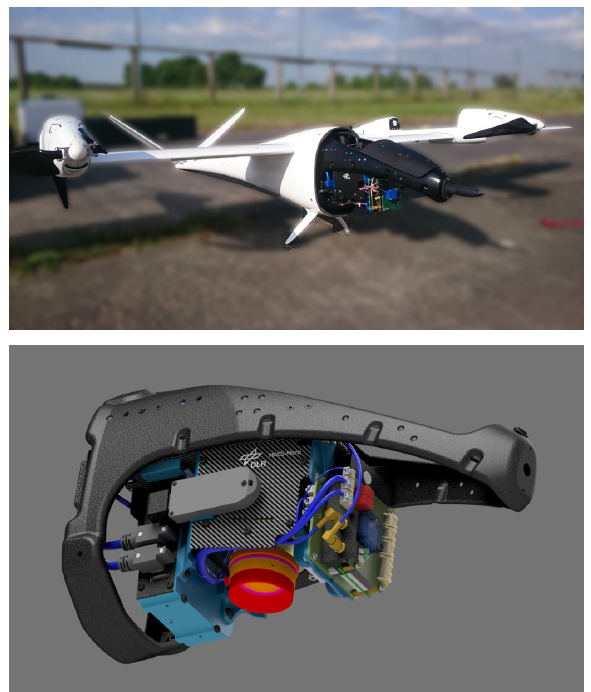
Figure 1. (top) Prototype of the camera system mounted to carrier, (bottom) CAD-model of the camera system KAI-16070 with Bayer pattern) and an industrial F-Mount lens